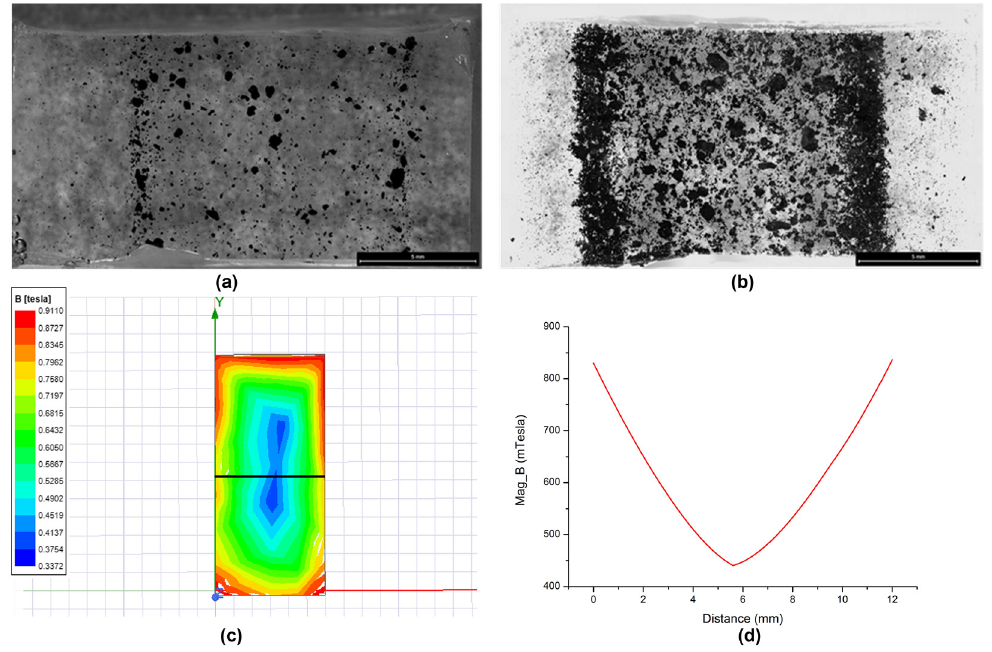
Figure 7. Magnetic pattern in MWCNT/PDMS samples with concentrations of ( a ) 0.01 and ( b ) 0.1 wt.% and ( c ) magnetic flux density profile on the surface of a permanent neodymium magnet, with ( d ) magnetic flux density in the region of the black line.